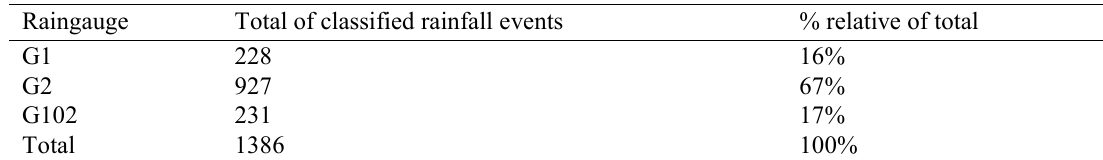
Table 2 Distribution of rainfall events.